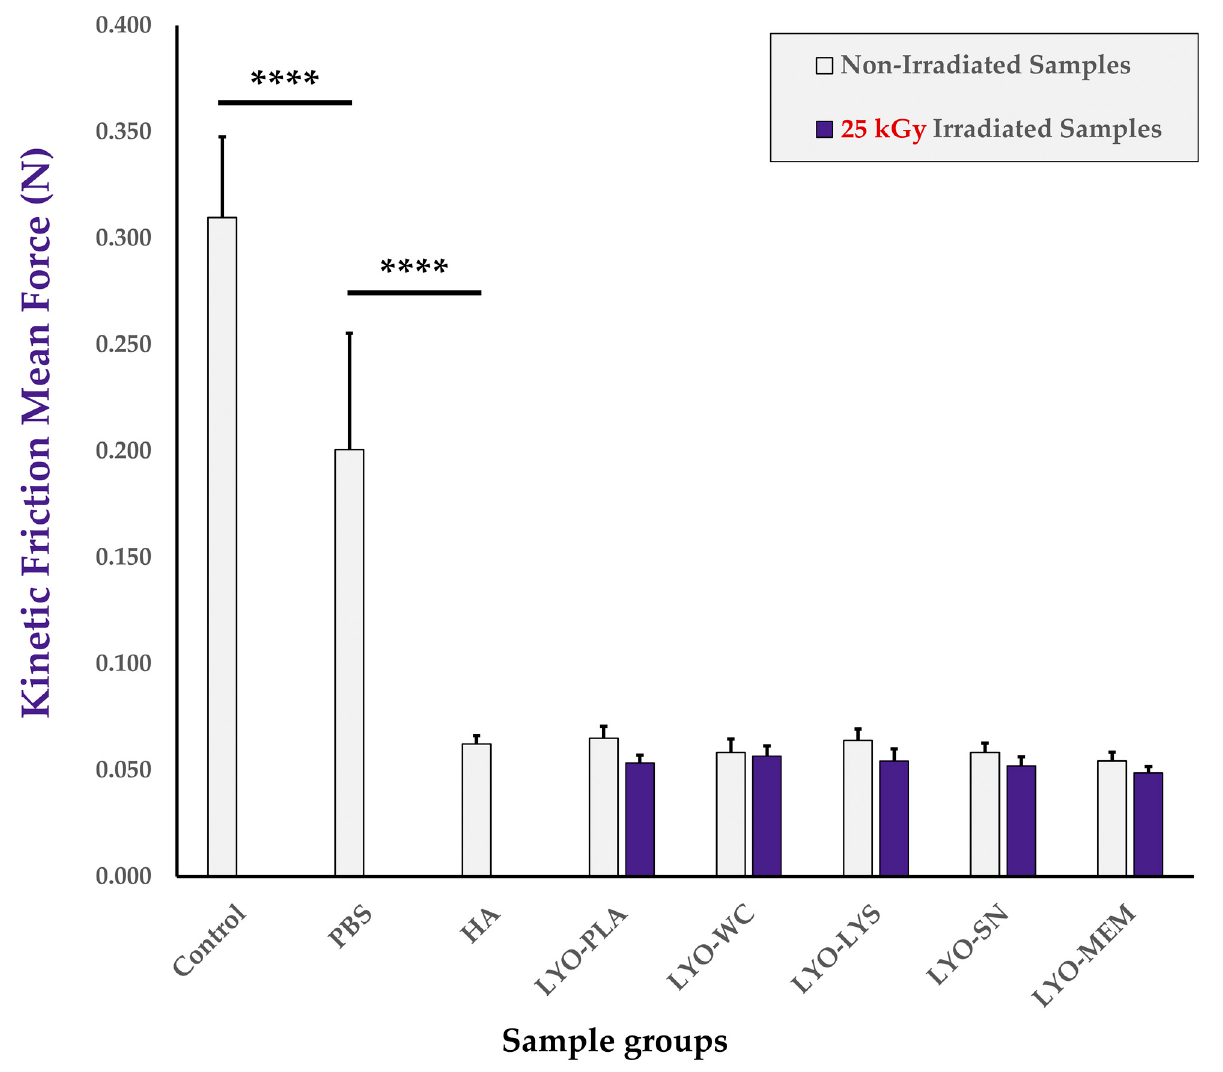
Figure 6. Results of the in vitro friction modulation capacity determination assay. Mean kinetic friction forces were determined without any lubricating agent between the base plate and the sliding bloc (i.e., “control” sample), with PBS or linear HA as a simple lubricant, or with the various non- irradiated and gamma-irradiated (i.e., 31 kGy) lyophilizates resuspended in HA before analysis (i.e., combination product samples). Extremely significant (i.e., **** or p value < 0.0001) differences were found between mean values for the control and both reference conditions. HA, hyaluronic acid; kGy, kiloGray; LYO-PLA, lyophilized placebo sample; LYO-LYS, lyophilized lysate fraction; LYO- MEM, lyophilized membrane fraction; LYO-SN, lyophilized soluble fraction; LYO-WC, lyophilized whole-cell fraction; N, Newton; PBS, phosphate-buffered saline.